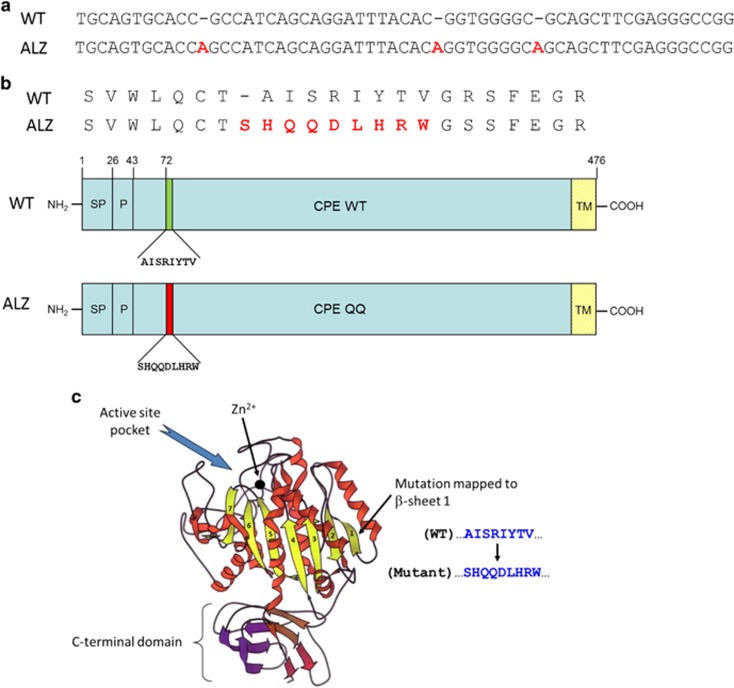
Nucleotide and amino acid sequence of human wild-type (WT) and Alzheimer's disease (AD) mutant carboxypeptidase E (CPE). (a) Inserted nucleotides in the mutant CPE sequence obtained from the human EST sequence of Alzheimer's patient, DA134138.1 (RNA from Invitrogen, Cat. #D6830-01) is shown in red. (b) Amino acid alignment of human WT-CPE and the mutant CPE, the inserted amino acids are shown in red. The schematic diagram shows the linear domain, where the nine amino acids are introduced in the mutant protein. As a pair of QQ amino acids is introduced, the mutant will be referred to as CPE-QQ. (c) X-ray crystal structure of the catalytic domain II of duck carboxypeptidase D (CPD, Protein Data Bank ID #1qmu), a homologous protein to CPE. The QQ mutation occurs in the first β-sheet of CPD (see arrow), which is associated in an anti-parallel manner with the β-sheet 2.